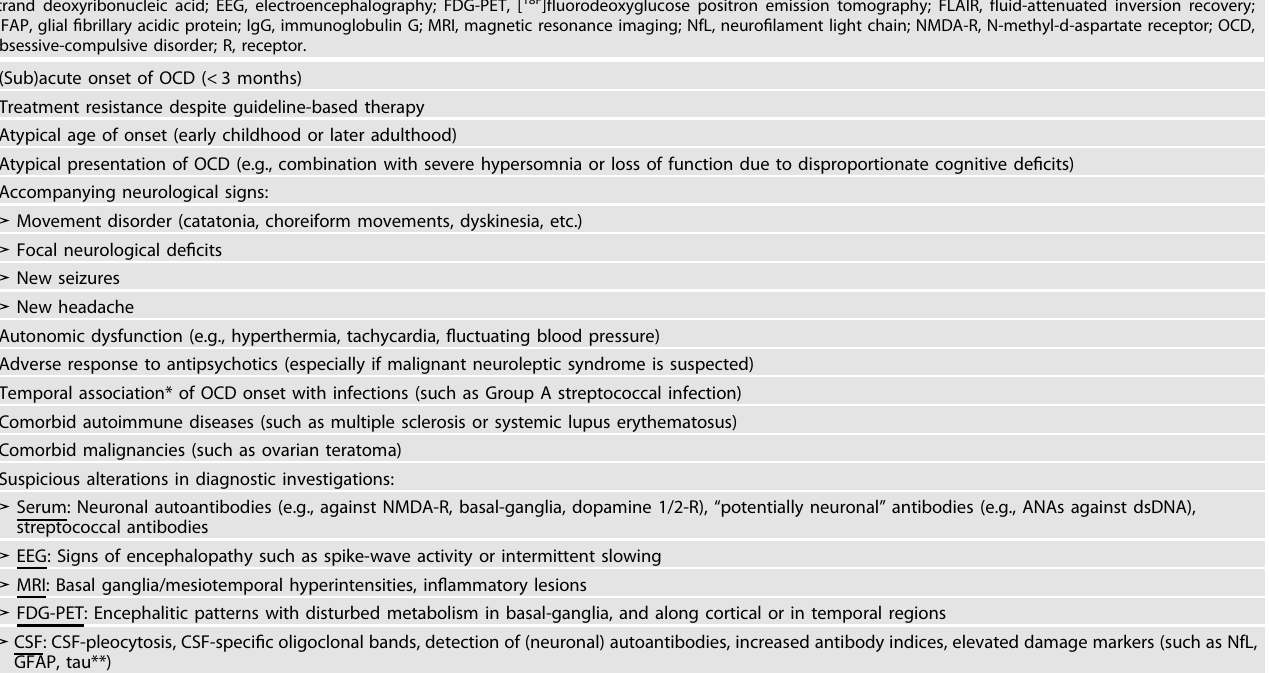
CSF: CSF-pleocytosis, CSF-speci fi c oligoclonal bands, detection of (neuronal) autoantibodies, increased antibody indices, elevated damage markers (such as NfL, GFAP,